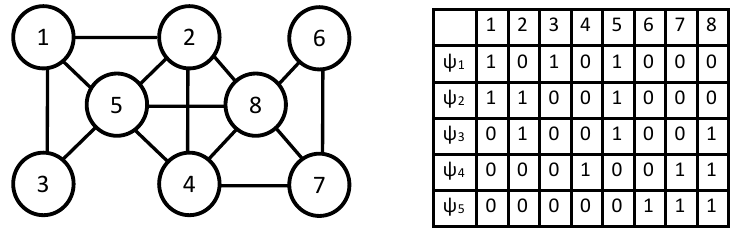
Figure A2. Example of complex problem of constrained heat integration and its corresponding clique matrix.